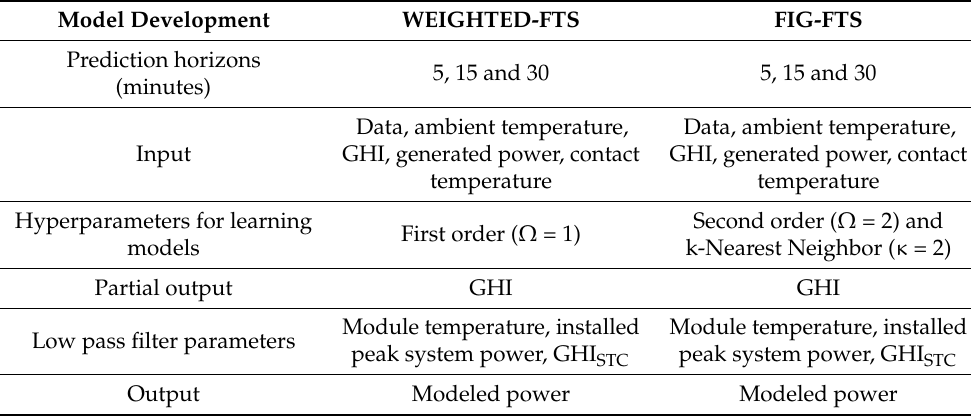
Table 6. Experimental setup of models, variables and prediction